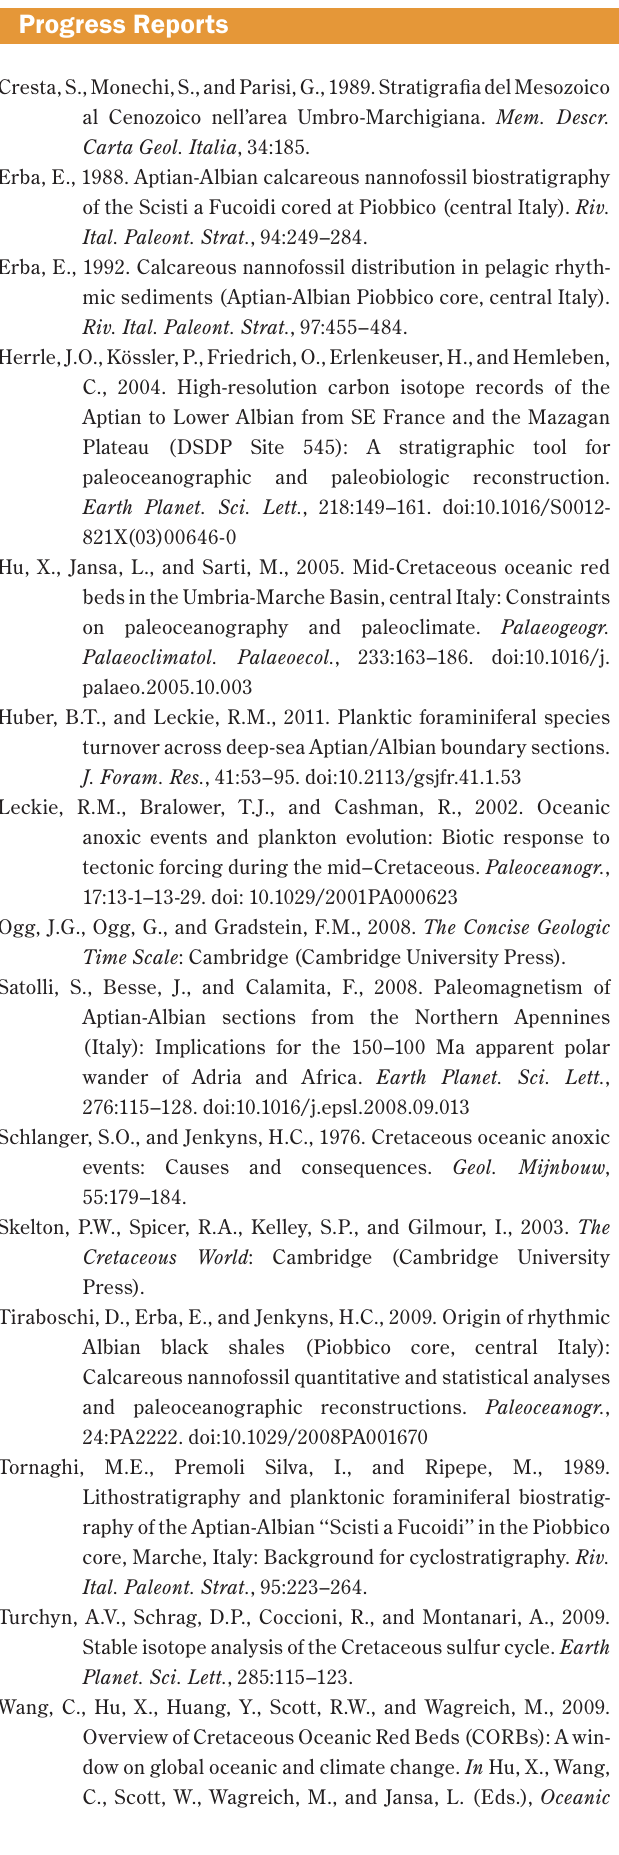
Figs. 3 and 4: Rodolfo Coccioni, Urbino